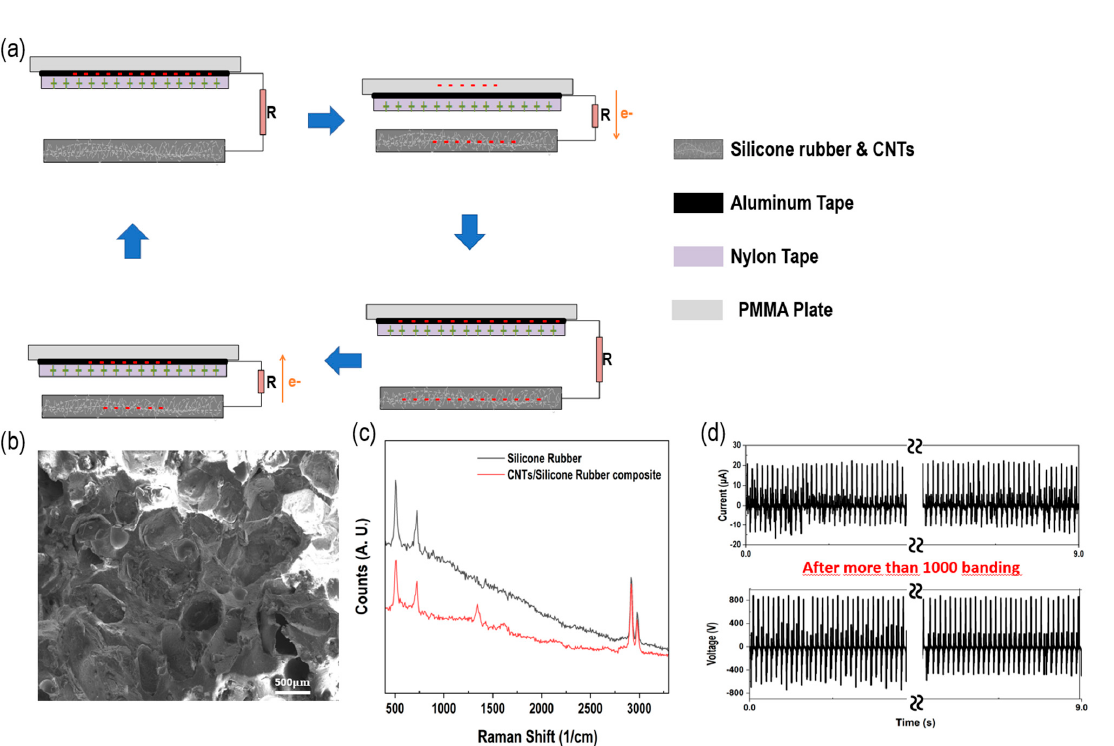
Figure 2. Schematic and features of FCS-TENG. ( a ) Schematic of the contact- and separation-mode mechanism. ( b ) Normal scanning electron microscope (Normal − SEM) image of flexible conductive sponge of FSC-TENG. ( c ) Raman spectra comparing silicon rubber with FCS − TENG (3.2 wt%). ( d ) Comparison of initial experimental values using a bending tester and experimental values after bending more than 1000 times.